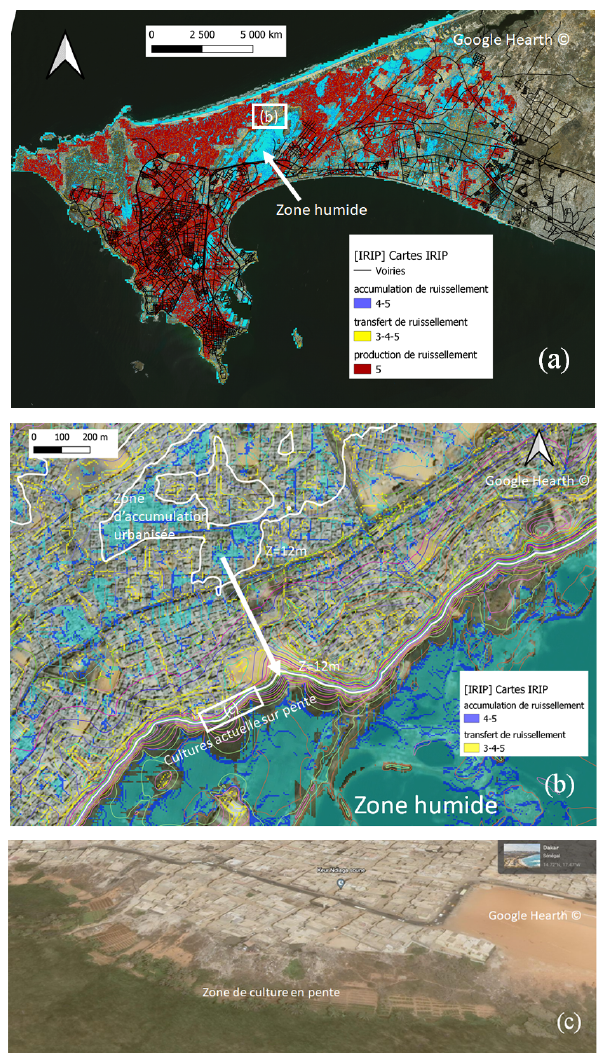
Figure 1. (a, b, c) Localisation des zones de production, transfert- érosion et dépôt-inondation dans la péninsule de